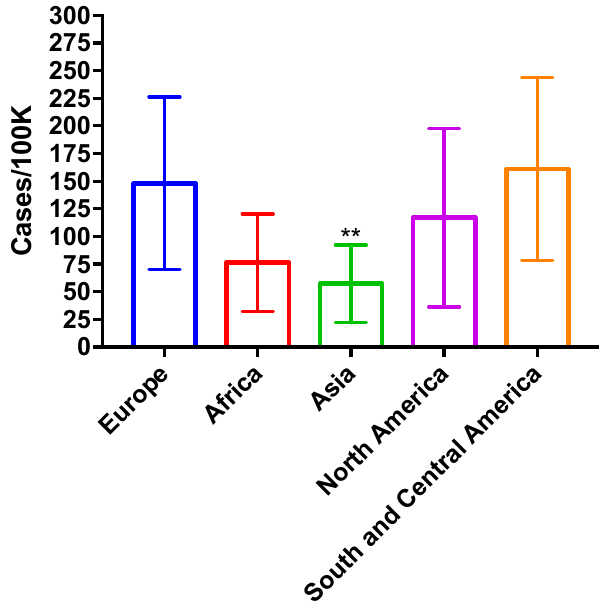
Figure 4. ABPA prevalence across countries. ** p < 0.01.